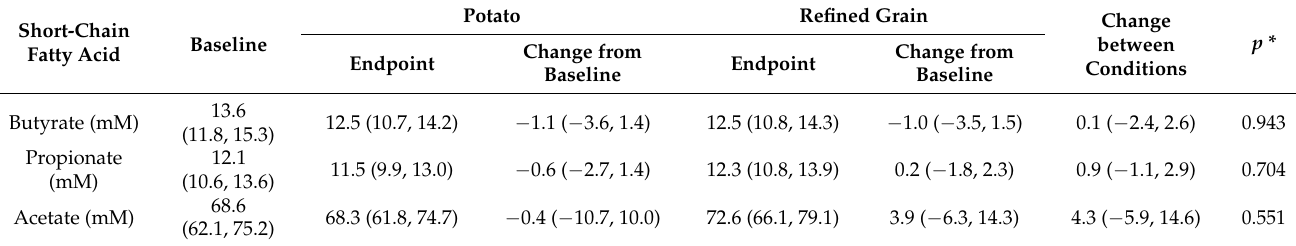
Table 2. Short-chain fatty acids, endpoint-to-endpoint means, and changes from baseline.